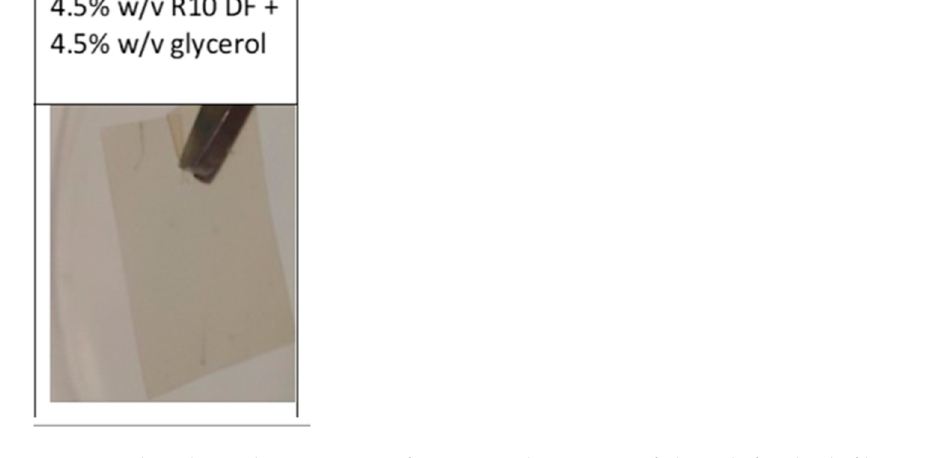
Figure 6. SEM image of the R10 fraction. 3.4. Dehydration Test The potential protective activity of SCW and of its derived fractions was evaluated in a particular type of tissue damage provoked from dehydration, as previously described in the model [19]. Cell viability (Figure 7) was reported as absorbance at 570 nm normal ‐ ized over unstressed cell monolayers as a positive control. Two concentrations, namely 4 and 2 g/L, for each fraction were tested.